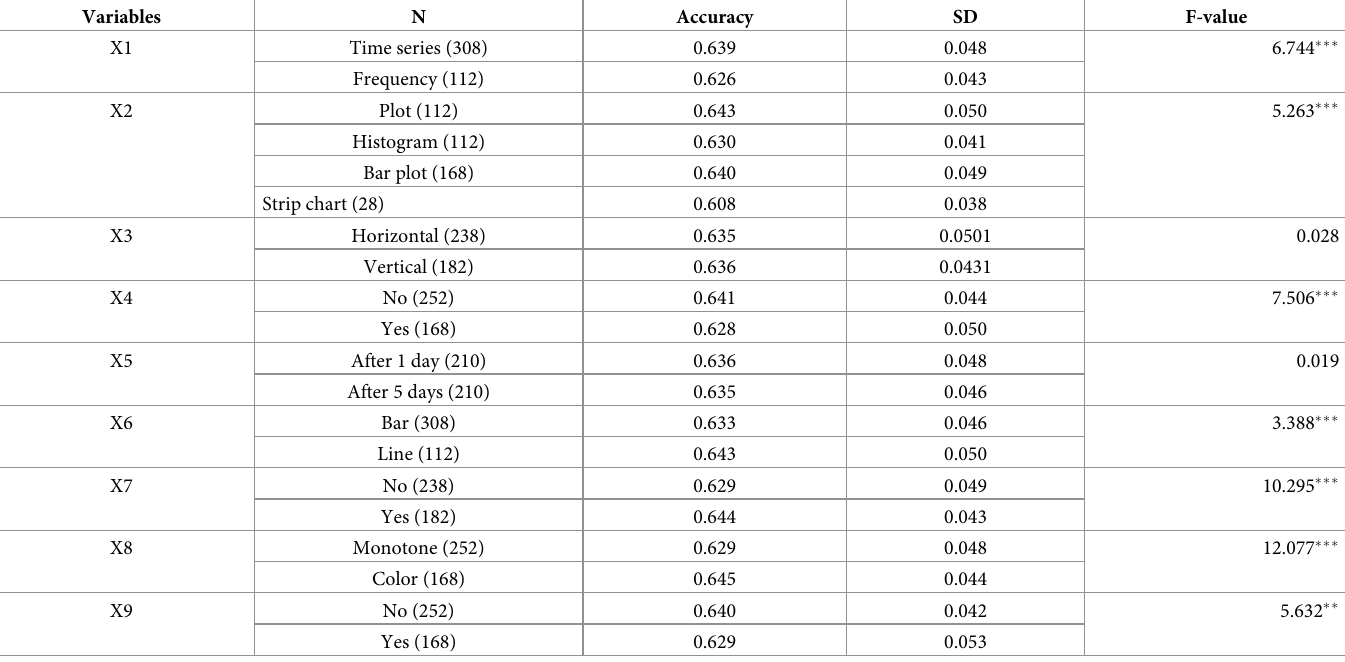
Table 5. Results of ANOVA analysis of the difference in accuracy between stock price predictions using image characteristics.